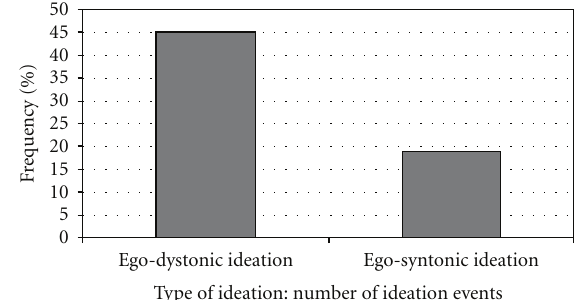
Figure 2: The proportion of reported ego-dystonic and ego- syntonic suicidal ideation during adequate treatment related to the total number of reported ego-dystonic and ego-syntonic ideation